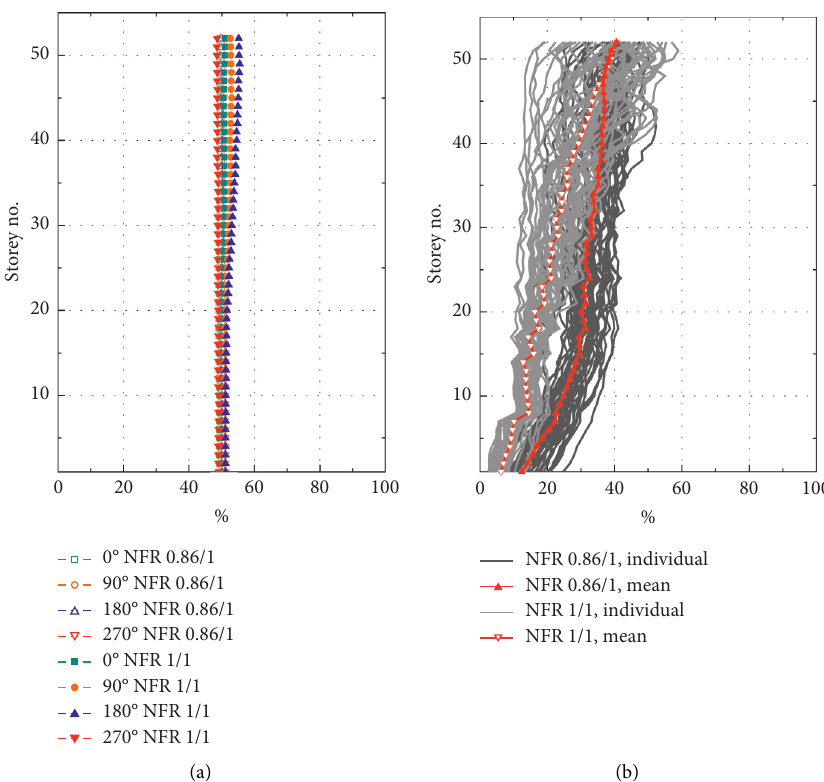
Figure 14: Variation of opposite-sign acceleration factor with height of buildings under (a) wind loads and (b) 44 earthquake